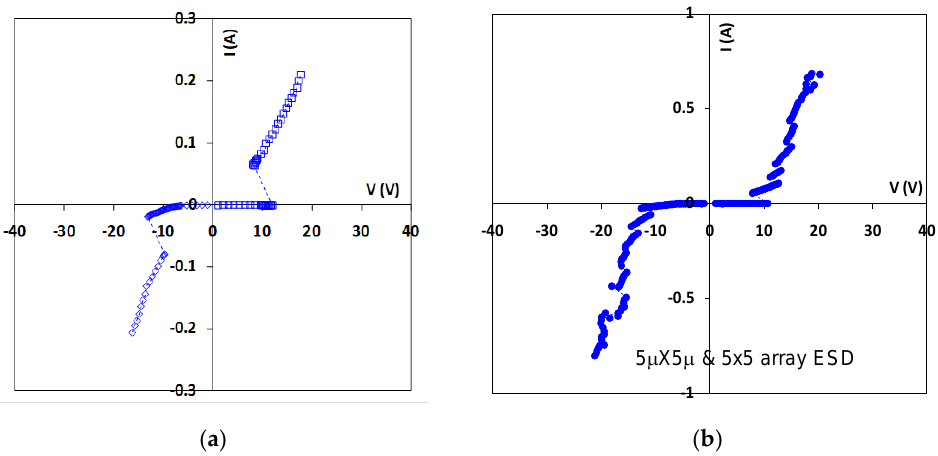
Figure 27. TLP testing of sample nano-crossbar ESD-protection structures shows dual-directional ESD discharge I-V characteristics: ( a ) single-node 5 μm × 5 μm ESD device, and ( b ) 5 × 5 nano-crossbar array ESD device [48].